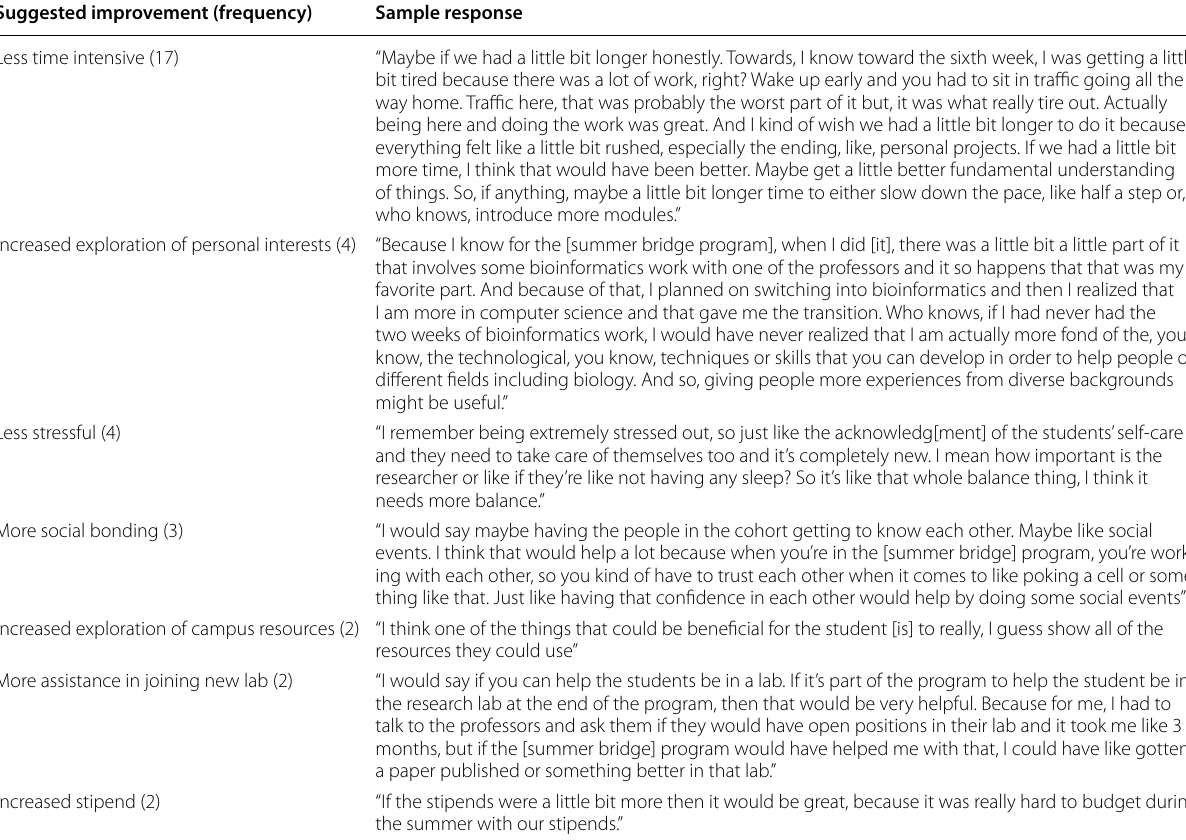
Table 6 Participant suggestions for improving future iterations of the summer bridge program. The 29 interview participants were asked if they had suggestions for improving the program, and all except two provided specific suggestions. Coded suggestions are in order from highest to lowest frequency, and sample responses are provided for each code. Codes with frequency greater than one are shown (34 total coded